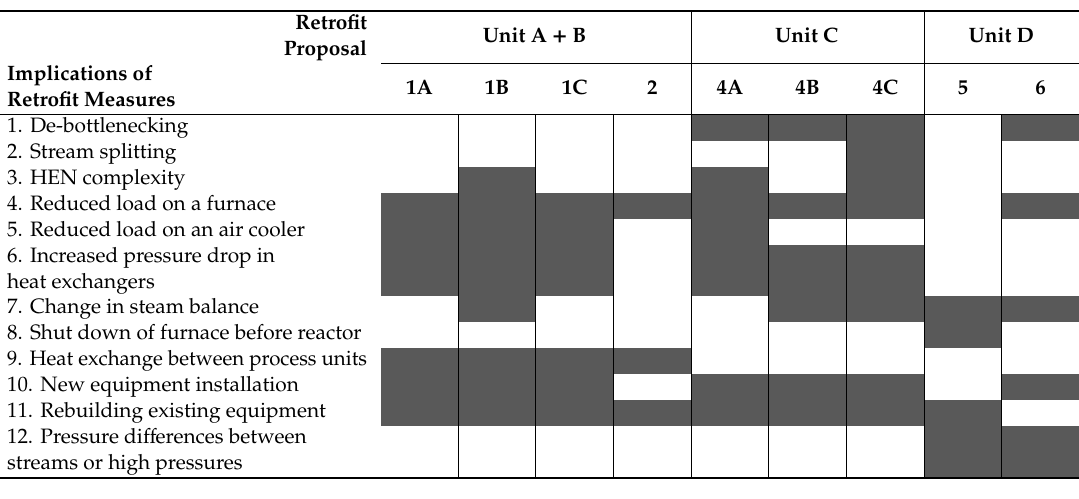
Table 3. Implications included in each retrofit